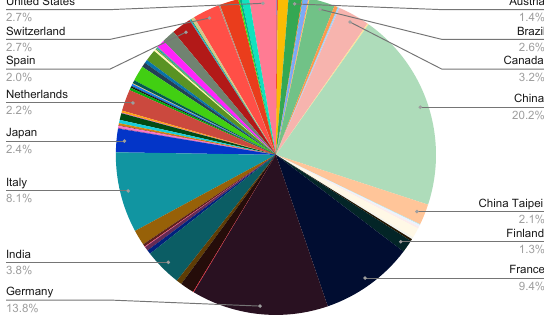
Figure 1. Papers were submitted by 1475 Authors from 77